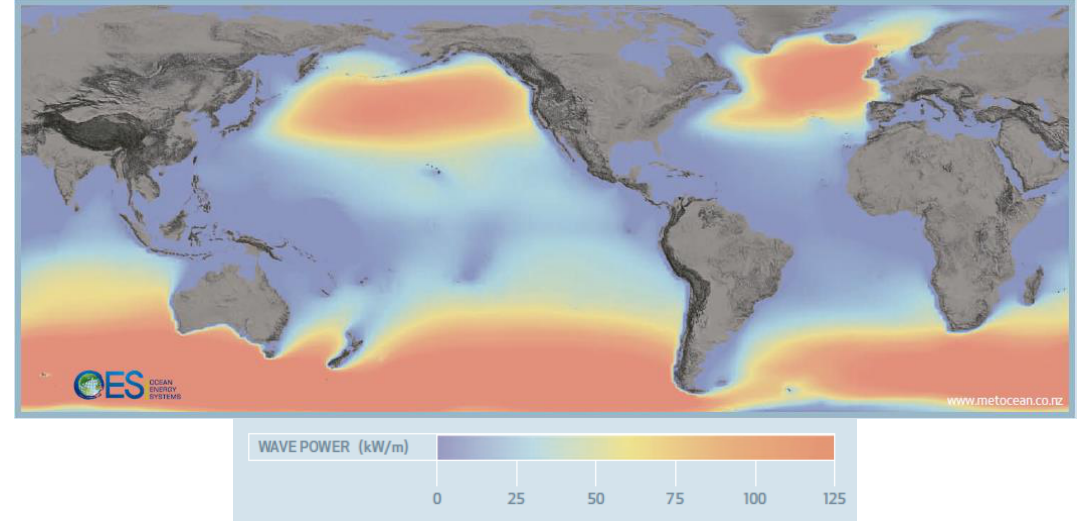
Figure 2. Wave power distribution, in kW/m (Reproduced with permission from [41,42]. International Energy Agency — Ocean Energy Systems, 2014, 2011).